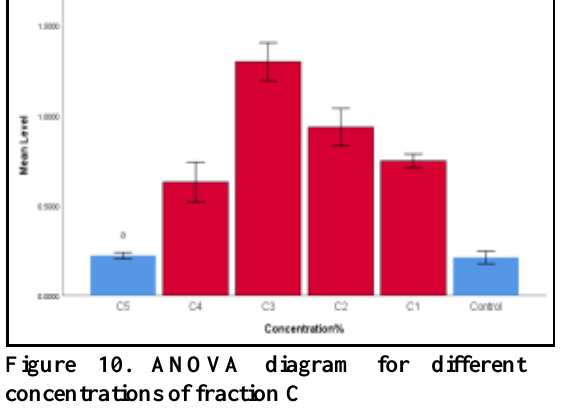
Figure 10. ANOVA diagram for different concentrations of fraction C